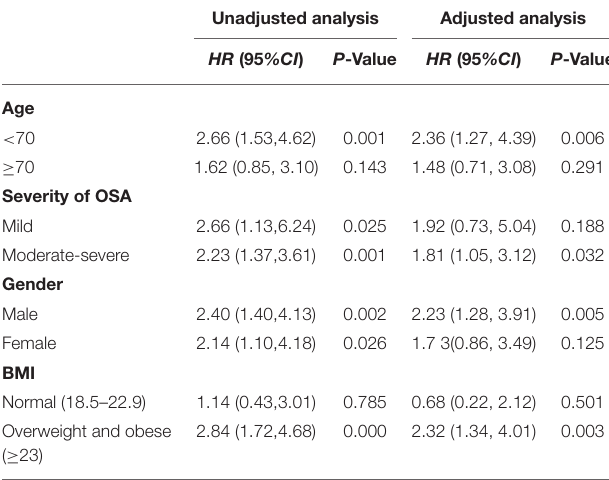
prevalent in our study population; it affected more than two thirds of the elderly patients with OSA. Second, patients with MetS had a higher incidence risk of MACE during the median 42-month follow-up when compared with patients without MetS. Moreover, the trend of MACE risk gradually increased in patients with ≥ 3 MetS components. Third, MetS conferred an approximately 2.0-fold higher risk for MACE, 1.54-fold risk for a composite of all events, and independently increased the risk of hospitalization for unstable angina. Finally, the risk of MACE was more strongly correlated with MetS in obese and overweight males aged < 70 years and in patients with moderate- severe